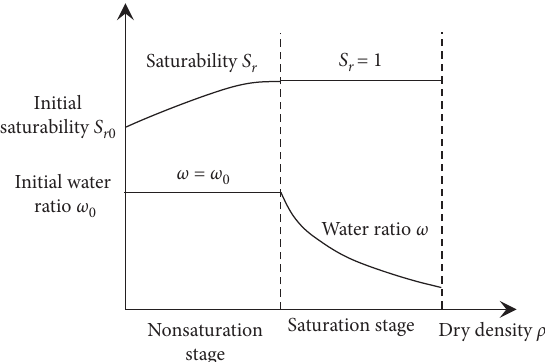
Figure 6: Variation of water ratio ω and saturability S